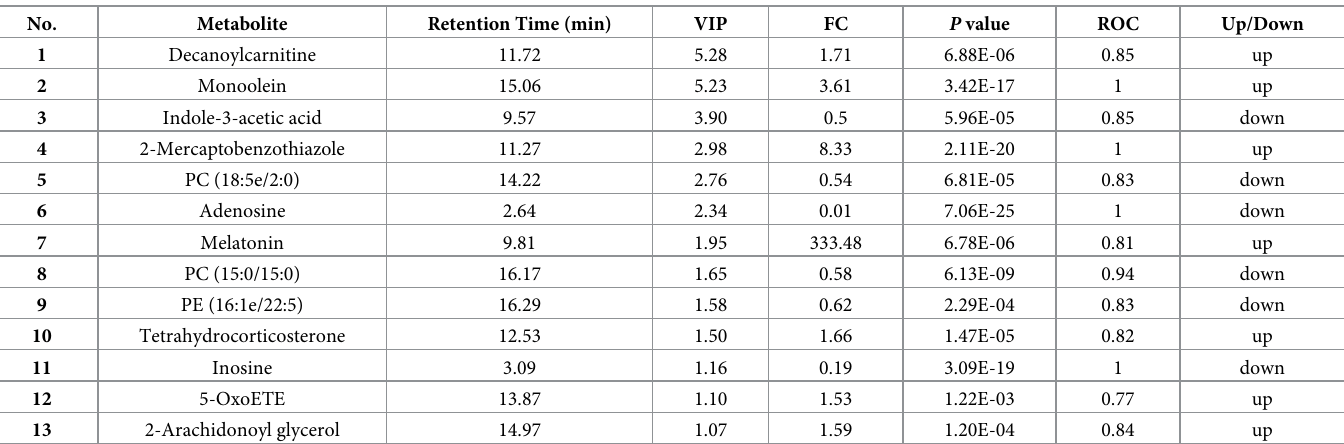
Table 2. The differential metabolites between Nor and